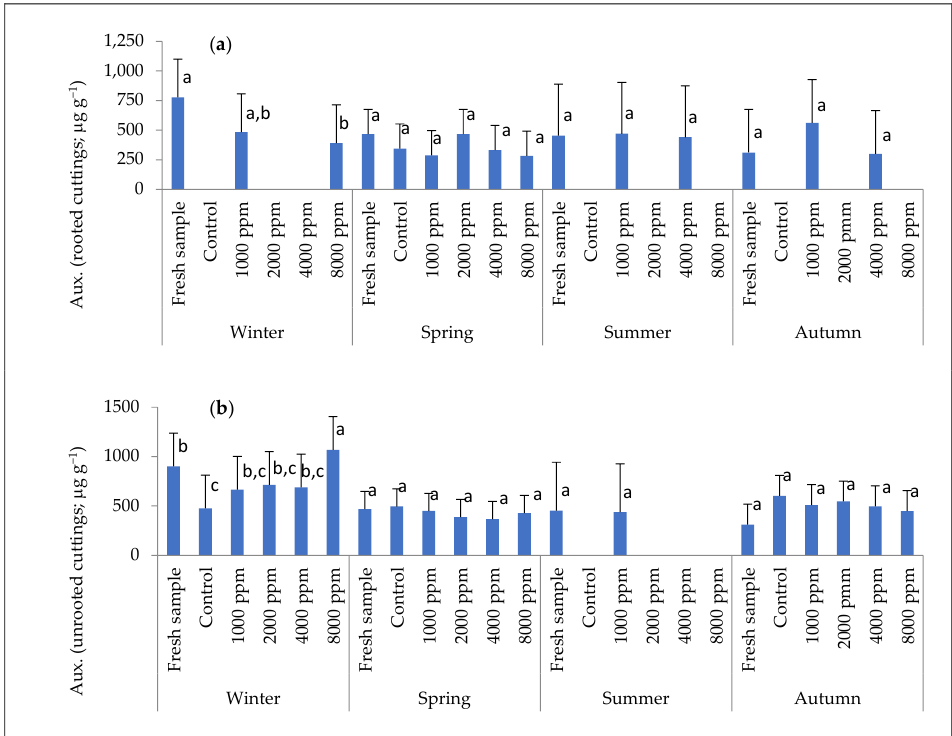
Figure 6. Mean auxin levels within seasons with different IBA treatments for ( a ) rooted and ( b ) unrooted cuttings. Mean values with the same letter were not significantly different at the 0.05 level (LSD test). Error bars: LSD intervals.